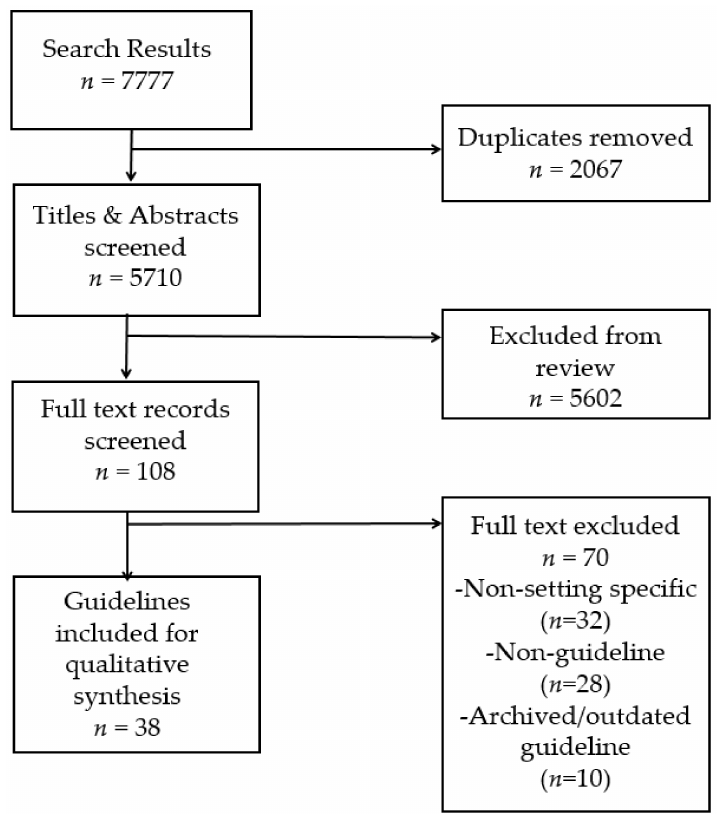
Figure 1. PRISMA flow